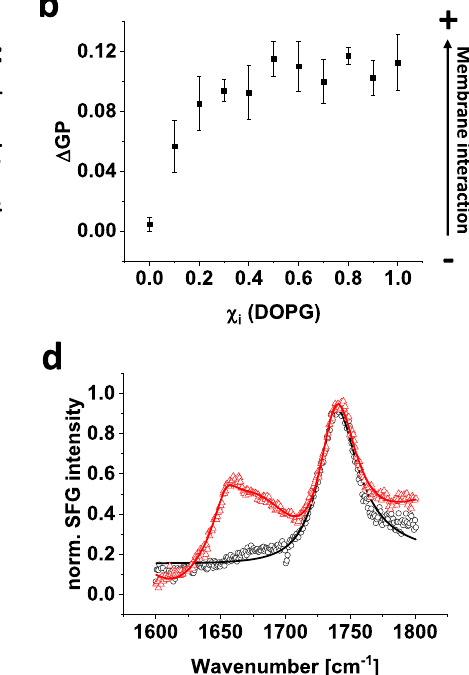
Fig. 5 | Membrane interaction of Syn DLP. a Fluorescence spectroscopy using Laurdan as a fl uorescent probe. LUVs were prepared with 50% DOPC and 50% of the indicated TM lipid ( w / w ) mixed with Laurdan at a 1:500 molar ratio. Laurdan fl uor- escenceemissionwasmeasuredafter30minincubationof Syn DLPandLUVsandthe Δ GP value was calculated from the spectra. Mean of three independent experiments (single measurements shown as circles) and error bars (S.D.) are shown. ns = not signi fi cant( P >0.05),* P <0.05,** P <0.01,*** P <0.001basedonatwo-sidedunpaired Student ’ s t-test. The Δ GP values of MGDG ( P =0.52), SQDG ( P =0.055), DOPG ( P =0.00028)orDGDG( P =0.14)arecomparedtoDOPC.Arrowindicatesincreasing membrane interaction. b LUVs were prepared with different DOPG/DOPC molar ratios (Laurdan added at a 1:500 molar ratio). Laurdan fl uorescence spectra were